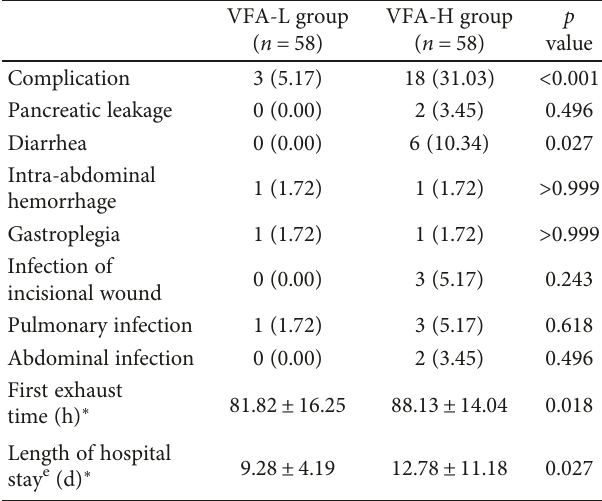
Table 6: Comparison of the postoperative outcomes between the low-VFA group and high-VFA group (cases (%)).